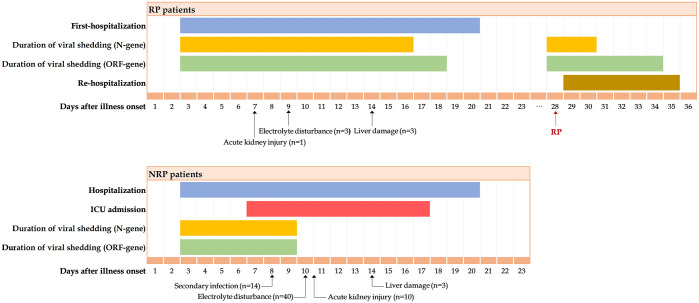
Clinical course, complications and duration of viral shedding from illness onset in patients hospitalized with COVID-19.Figure shows median duration of hospitalization and positive nucleic acid Ct value and onset of several complications. RP = redetectable as positive. NRP = non-redetectable as positive.